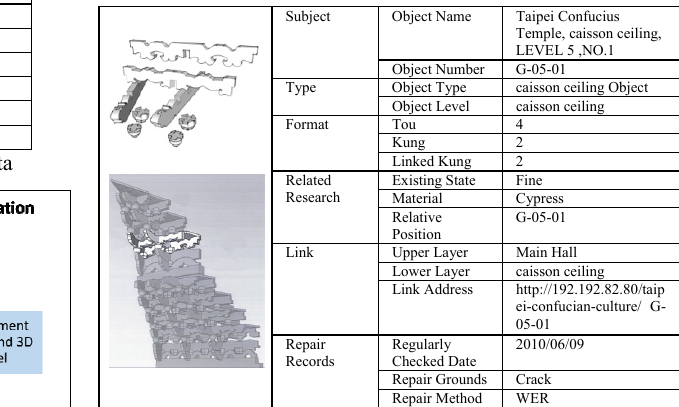
Table 2. The metadata table for the element and frame (Object)